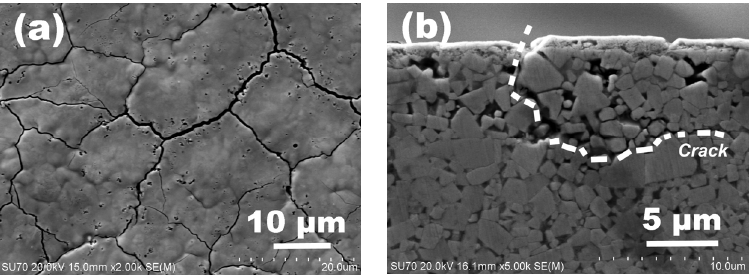
Figure 7. ( a ) Surface and ( b ) cross-sectional aspects of WC-6% Co samples after 35 pulses of HCPEB irradiation.